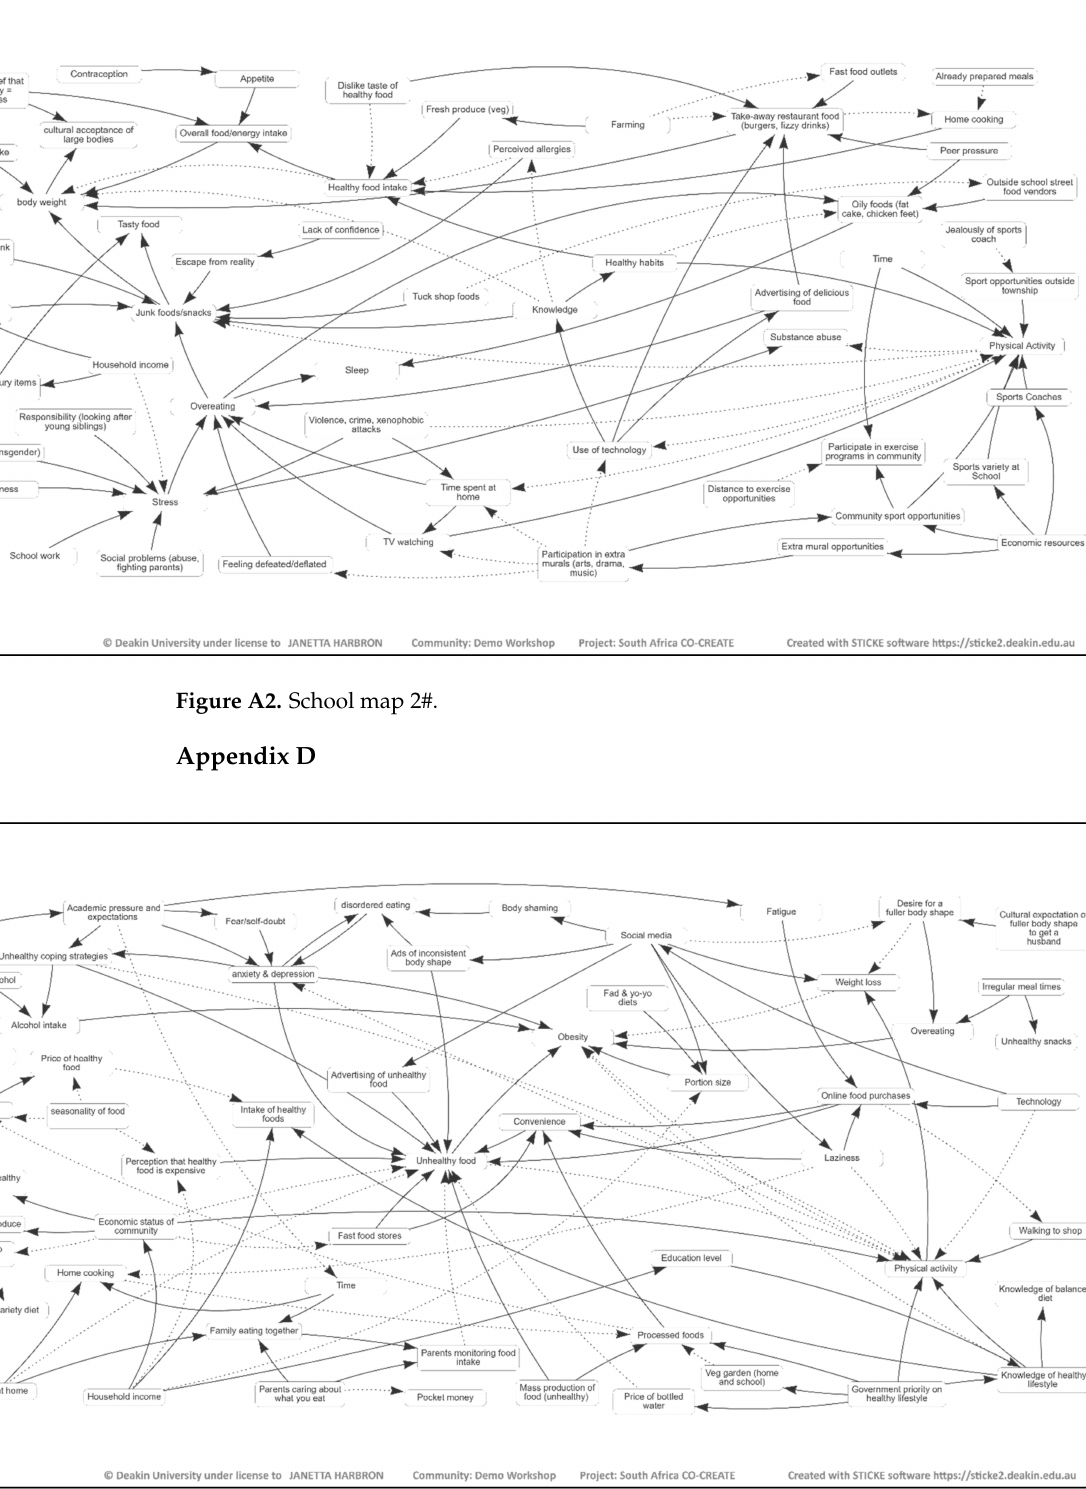
Figure A3. School map